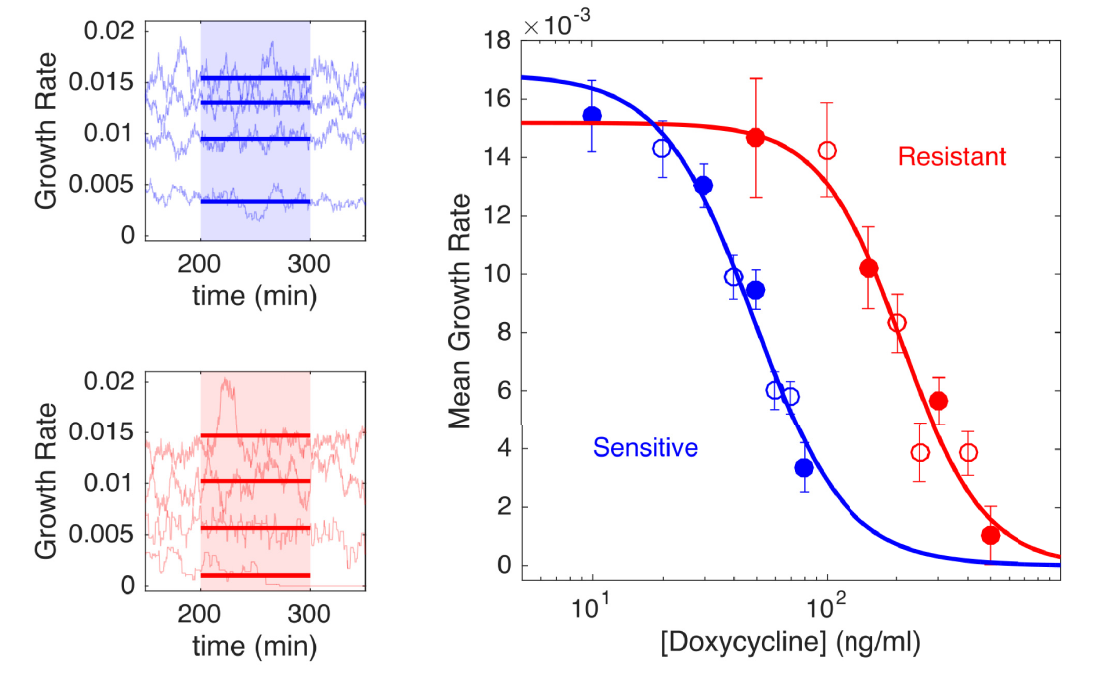
Fig 2. Resistant cells exhibit increased resistance to doxycycline and a small fitness cost. Left panels: per capita growth rate in bioreactors for ancestral (sensitive, blue) and resistant (red) populations exposed to increasing concentrations of doxycycline (top to bottom in each panel). Real-time per capita growth rate (light blue or red curves) is estimated from flow rates required to maintain constant cell density at each drug concentration (Methods). Mean growth rate (thick solid lines) is estimated between 200 and 300 minutes post–drug addition (shaded regions), when the system has reached steady state. Doxycycline concentrations are 10, 30, 50, and 80 ng/mL (top panel, top to bottom) and 50, 150, 300, and 500 ng/mL (bottom panel, top to bottom). Right panel: dose-response curve for sensitive (blue) and resistant (red) populations. Circles are time-averaged growth rates between 200 and 300 minutes post–drug addition (shaded regions in [A]), with error bars ± one standard deviation over the measured interval; filled circles correspond to the specific examples shown in left panels. Drug-free growth rates are 0.017 ± 0.001 minutes − 1 (sensitive) and 0.015 ± 0.002 minutes − 1 (resistant), indicating that resistant cells exhibit a fitness cost. Solid lines, fit to Hill-like dose-response function r = r 0 (1+( D / h ) k ) − 1 , with r the growth rate, D the drug concentration, r 0 the growth in the absence of drug, h the IC 50 , and k the Hill coefficient. IC 50 values are estimated to be h = 49 ng/mL (sensitive cells) and h = 210 ng/mL (resistant cells). Data are deposited in the Dryad repository: